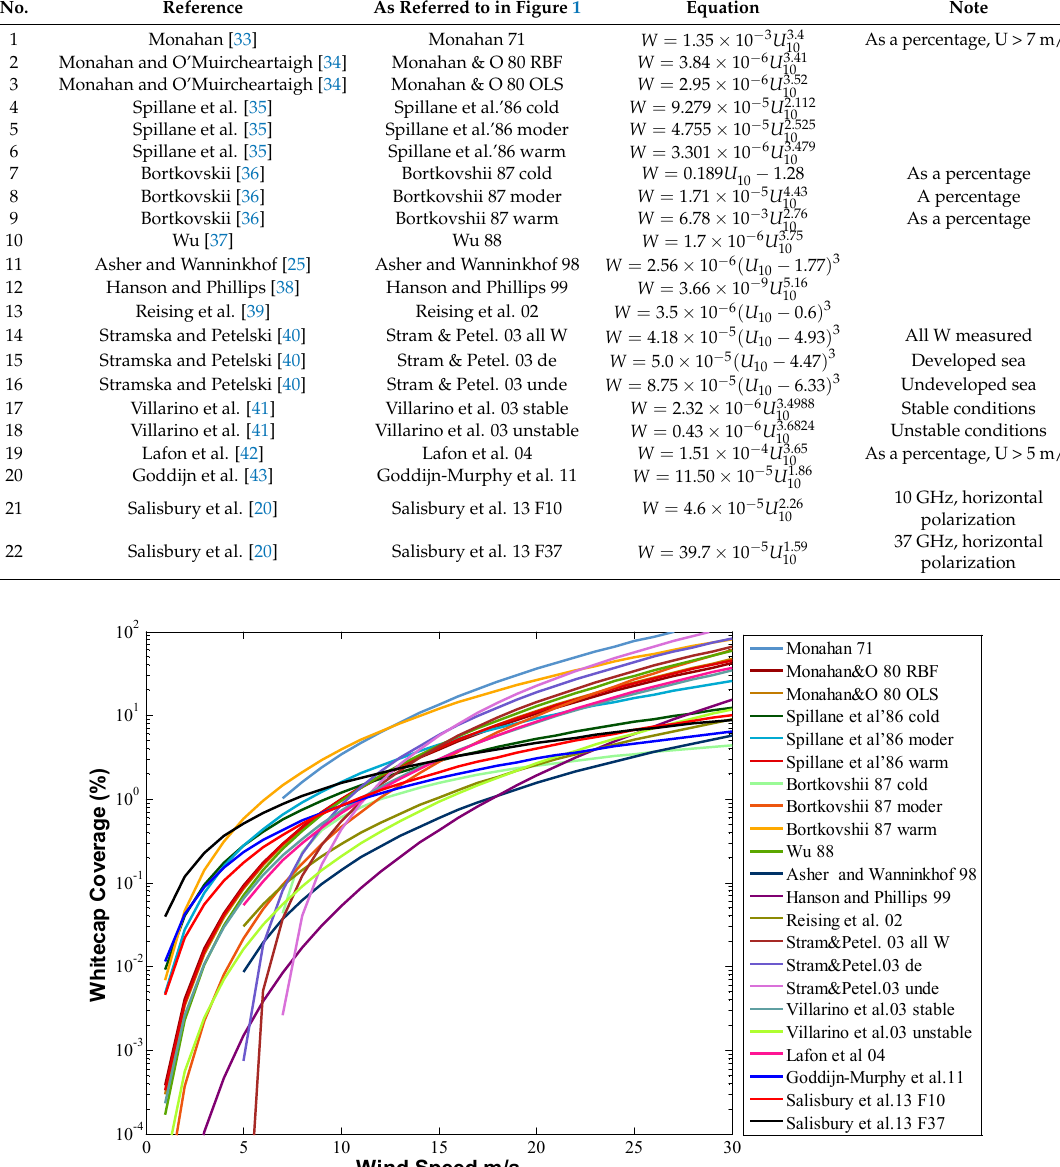
Figure 1. Wind speed empirical relationships. See Table 1 for details.